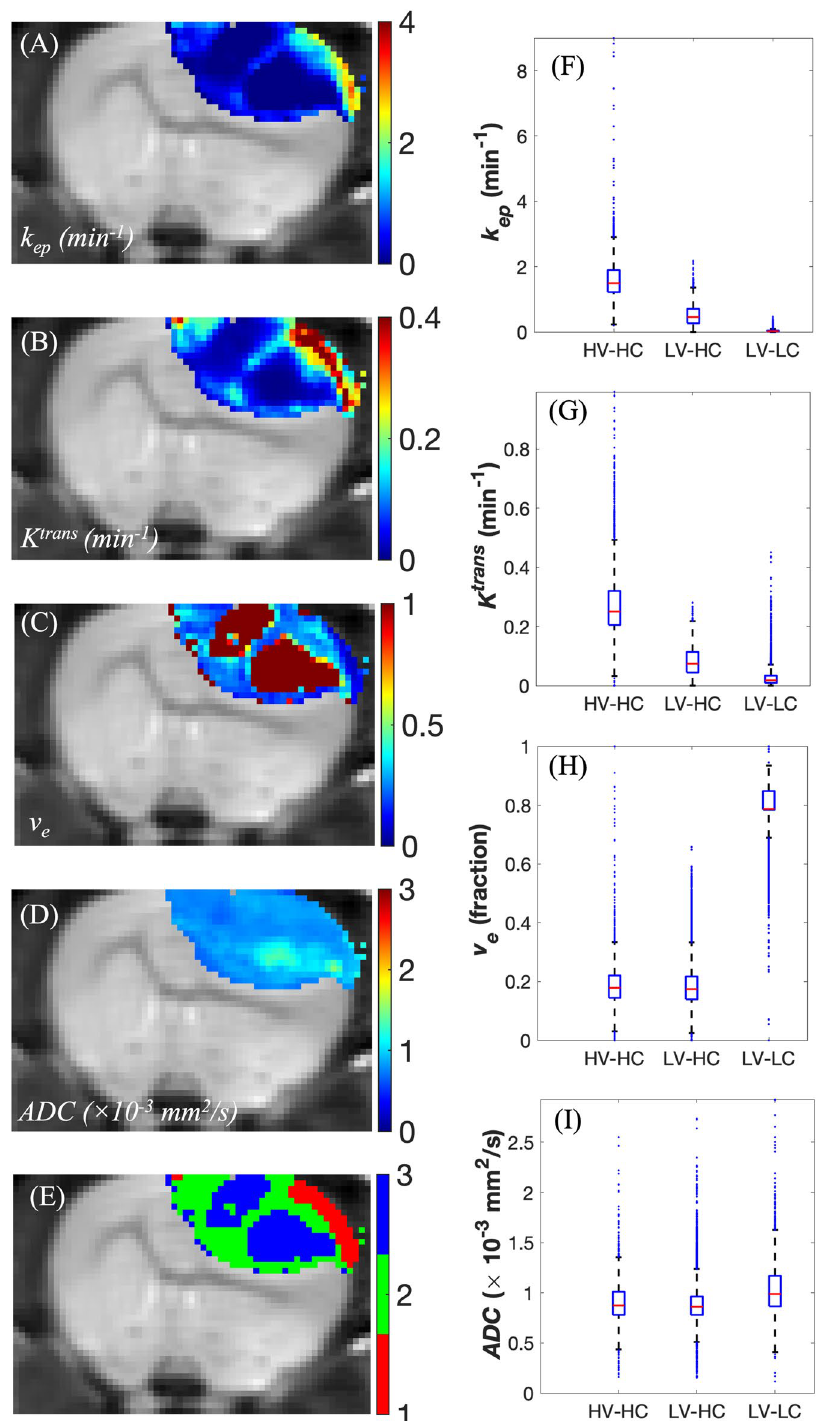
Figure 4. Quantitative parameter maps and tumor habitat map for a representative rat at the third imaging visit. ( A - D ) depict the k ep (min −1 ), v e , K trans (min −1 ), and ADC (10 −3 s/mm 2 ) maps, respectively. ( E ) This is the tumor habitat map where HV-HC is in red, LV-HC is in green, and LV-LC is in blue. The LV-LC cluster spatially localizes to the center of the tumor with high values of v e and high values of the ADC, which align with expected observations in necrotic regions. The HV-HC habitat corresponds to the edge of the tumor, which exhibits characteristic high values of K trans and k ep most likely due to breakdown of the blood-brain-barrier. Lastly, the LV-HC region surrounds the necrotic regions, consisting of voxels with mid-range values of K trans and lower values of v e compared to the LV-LC habitat. ( F - I ) are the quantitative parameter distributions from each habitat, grouped by k ep , K trans , v e , and ADC, respectively. All four parameter distributions differ significantly between the three habitats ( p <